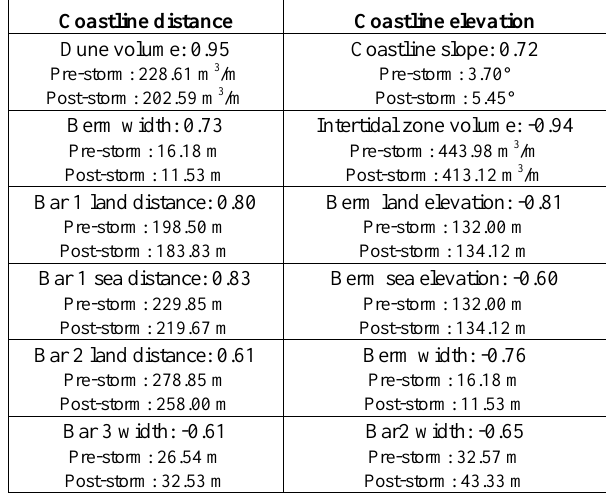
Table 3. Summary of high correlation coefficients